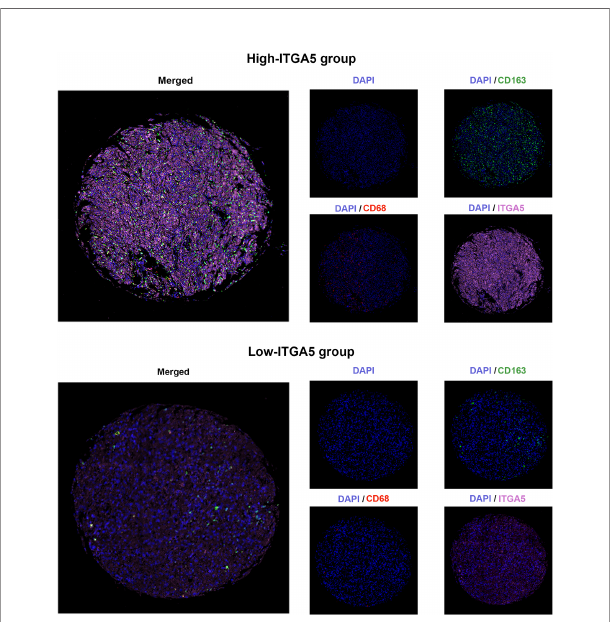
FIGURE 6 | The multiple immuno fl uorescence staining of ITGA5, CD68, and CD163 in